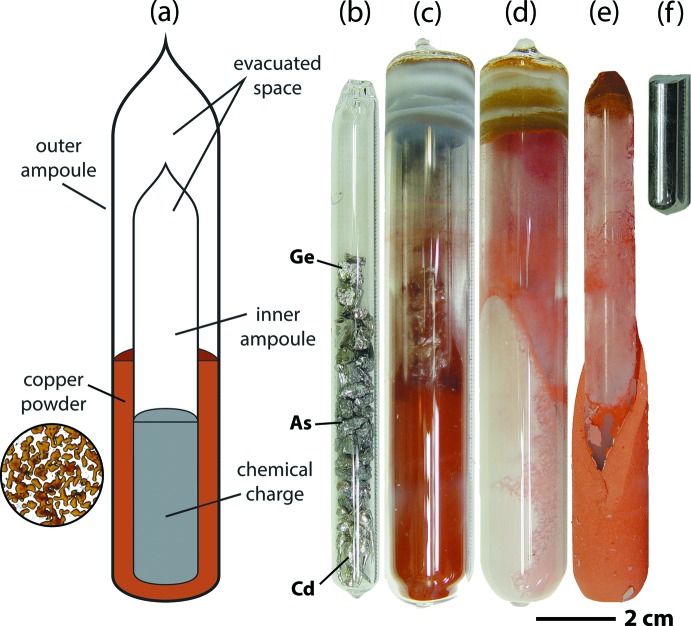
(a) Schematic of double-containment ampoule setup showing a high magnification of the sintered copper powder. (b–f) Progression of steps involved in the double-containment ampoule process [with scalebar for (b)–(f)] showing (b) elements packed in an evacuated and sealed 10×12 mm inner FQ tube, (c) the inner ampoule loaded into an evacuated and sealed outer 19×22 mm FQ tube containing copper powder, (d) the assembly after heat treatment, (e) the assembly removed from the outer ampoule, and (f) the ingot removed from the inner ampoule. This figure was recreated with permission from the American Ceramic Society.